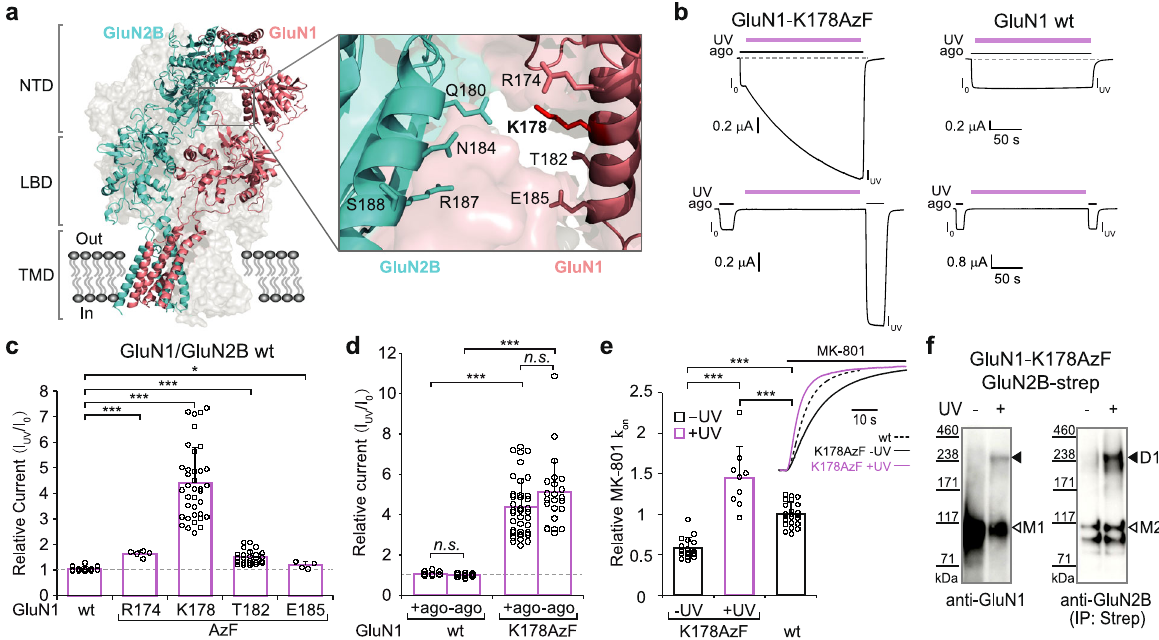
Fig. 1 NTD heterodimer photocrosslinking locks GluN2B receptors in a high Po mode. a Structure of the full-length GluN1/GluN2B receptor in the inhibited state (side view; PDB 4PE5, Ref. 10 and see “ Methods ” ). The receptor, composed of two GluN1 subunits and two GluN2B subunits, assembles as a dimer-of-dimers and display a layered arrangement (NTD, LBD, TMD). The two front subunits are shown in cartoon representation while the two subunits in the back are displayed in space- fi lled. NTD N-terminal domain, LBD ligand-binding domain also named agonist-binding domain, TMD transmembrane domain. Inset: enlargement of the GluN1-GluN2B NTD heterodimer lower lobe region. Residues in GluN1 and GluN2B subunits subjected to amber mutation (allowing incorporation of photo-cross-linker amino acids) are represented as sticks. b Representative current traces from oocytes expressing GluN1-K178AzF/GluN2B mutant (left) and wild-type (wt, right) receptors during UV illumination (365 nm) in the presence (top) or absence (bottom) of agonists. ago, for agonists (glutamate and glycine, 100 µ M each). c Change in current amplitude upon UV illumination (I uv /I o ) of wild-type (wt) GluN1/ GluN2B receptors and various GluN1-AzF/GluN2B mutant receptors. Values are: 1.04± 0.09 ( n = 16) for wt, 1.65 ± 0.12 ( n = 5) for GluN1-R174AzF, 4.39 ±